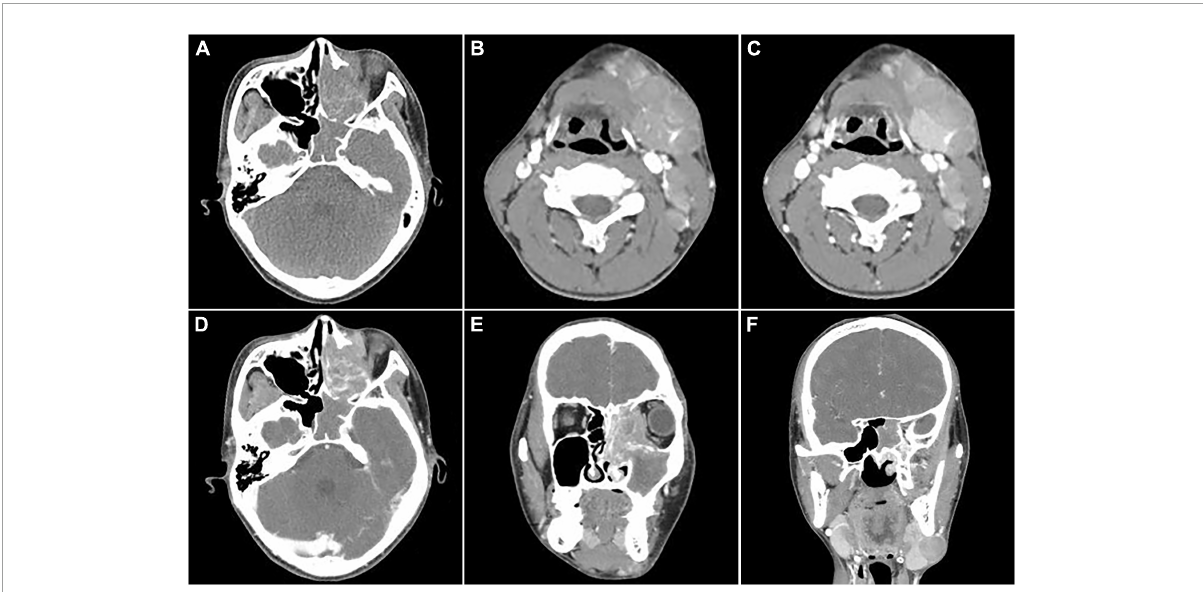
FIGURE1 Computed tomography (CT) images of nasal sinus alveolar rhabdomyosarcoma (ARMS) in case 1. (A) Plain image showed the lesion at the left nasal cavity and sphenoidal sinus with homogenous density and osteolytic destruction inside. (B) The arterial phase contrast image showed circular enhancement in the left mandibular and cervical masses. ( C–F ; C,D , transverse; E,F , coronal) Venous phase images showed bilateral lesions in the neck and parapharyngeal regions with heterogenous enhancement, which invaded the inner wall of the left orbit, the ethmoid inward, and the frontal lobe upward.